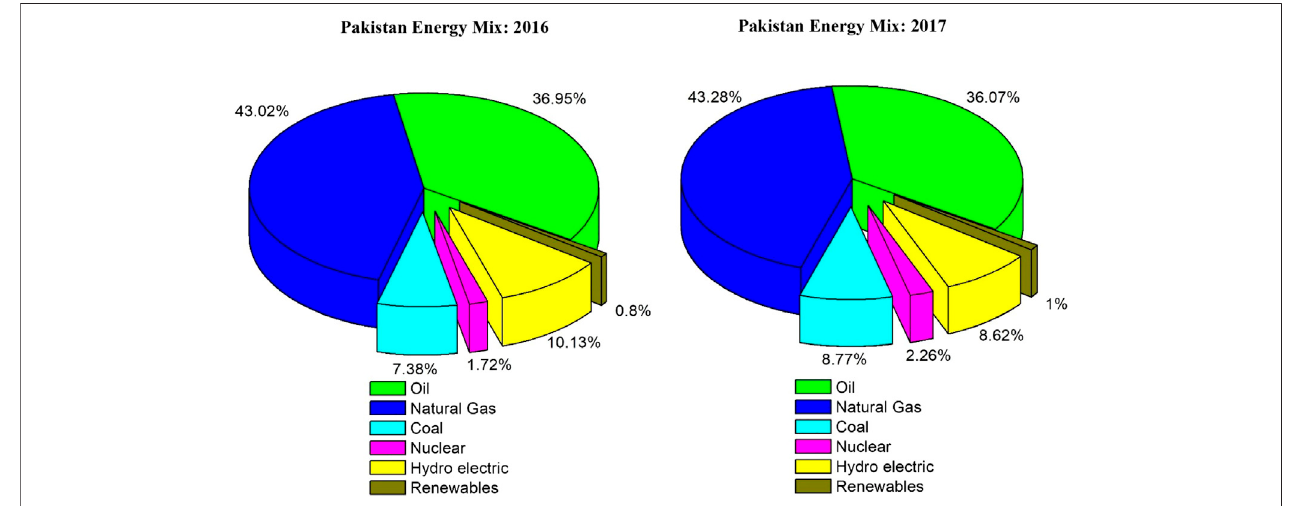
FIGURE 17 | The primary energy mix of Pakistan in 2016 and 2017 (Source BP Statistics 2018).